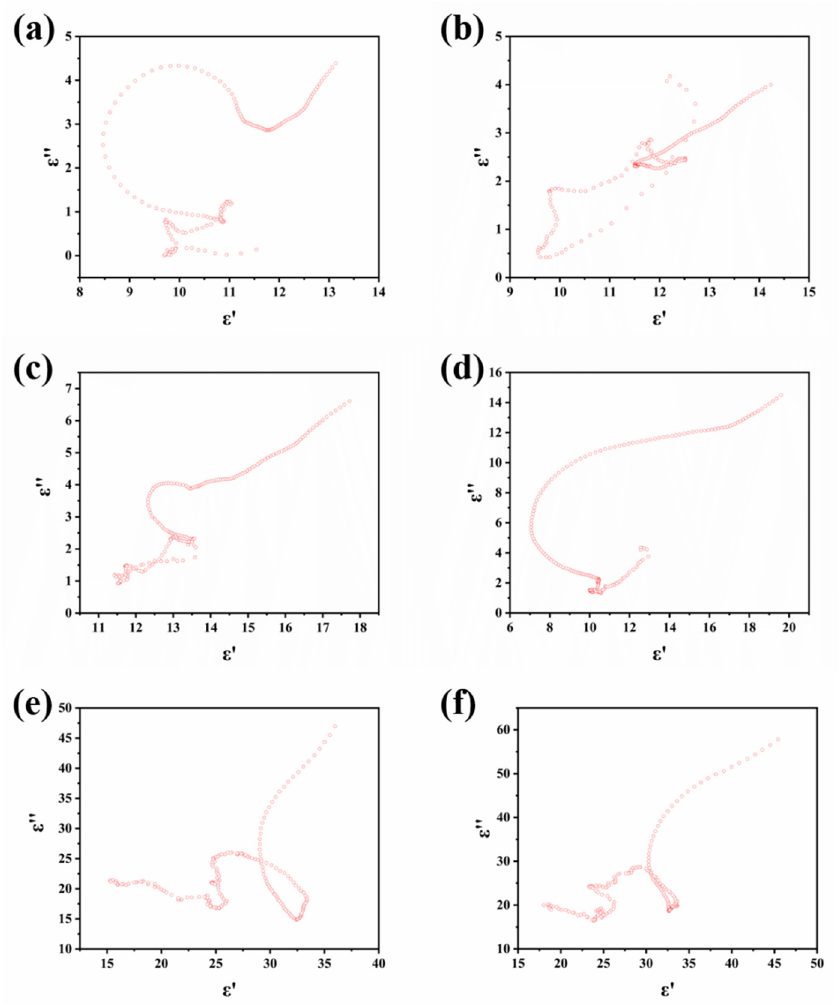
Figure 7. Cole–Cole semicircle of samples ( a ) CuPc-600, ( b ) CuPc-700, ( c ) CuPc-800, ( d ) CuPc-900, ( e ) CuPc-900/HCl, and ( f ) Pc.